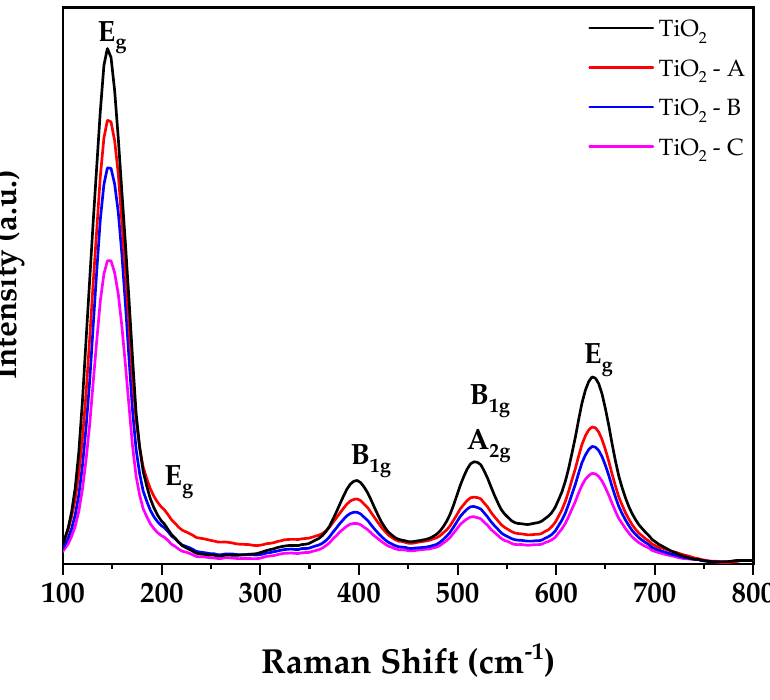
Figure 3. Raman spectra of spectra of pure and doped TiO 2.